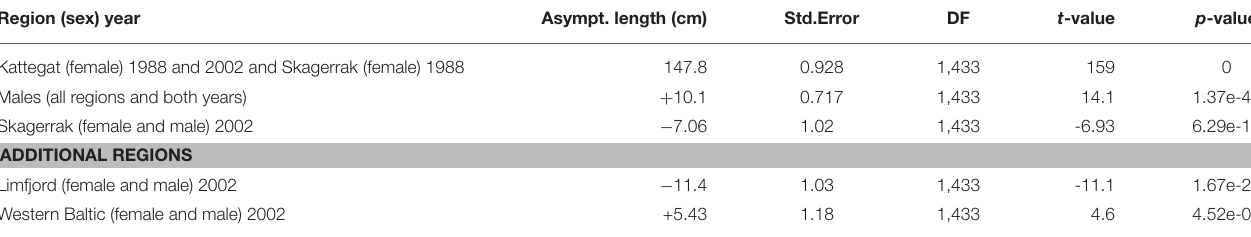
TABLE 2 | Fixed effects in Analysis 1: comparing growth curves among regions and sampling years with a mixed regression model. Region (sex) year Asympt. length